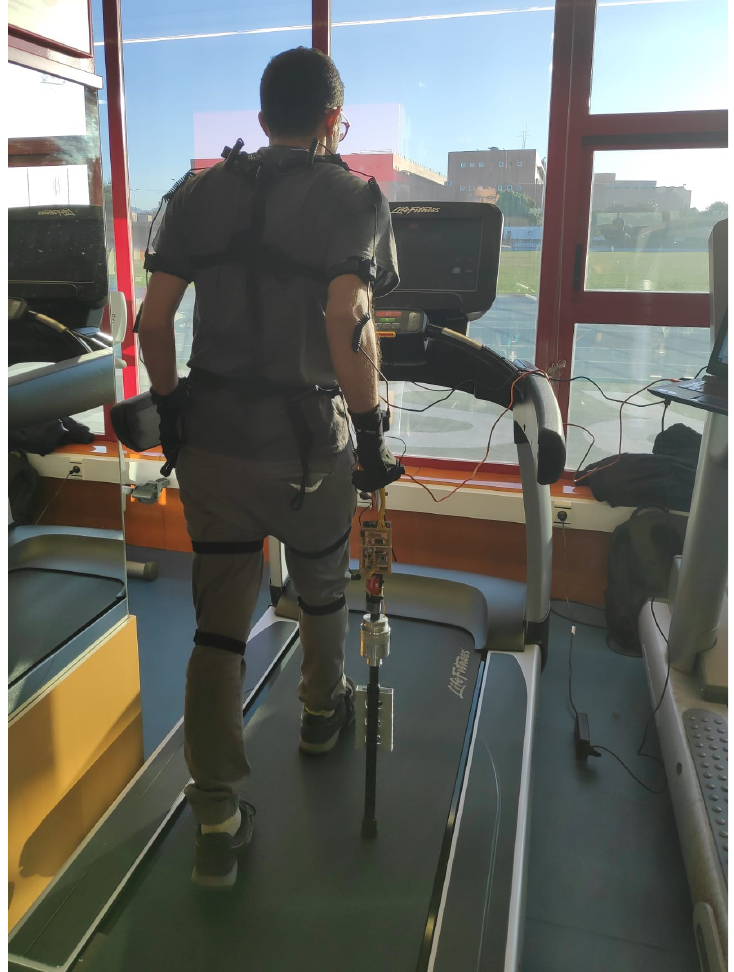
Figure 9. Volunteer taking part in the preliminary trials during the experiment